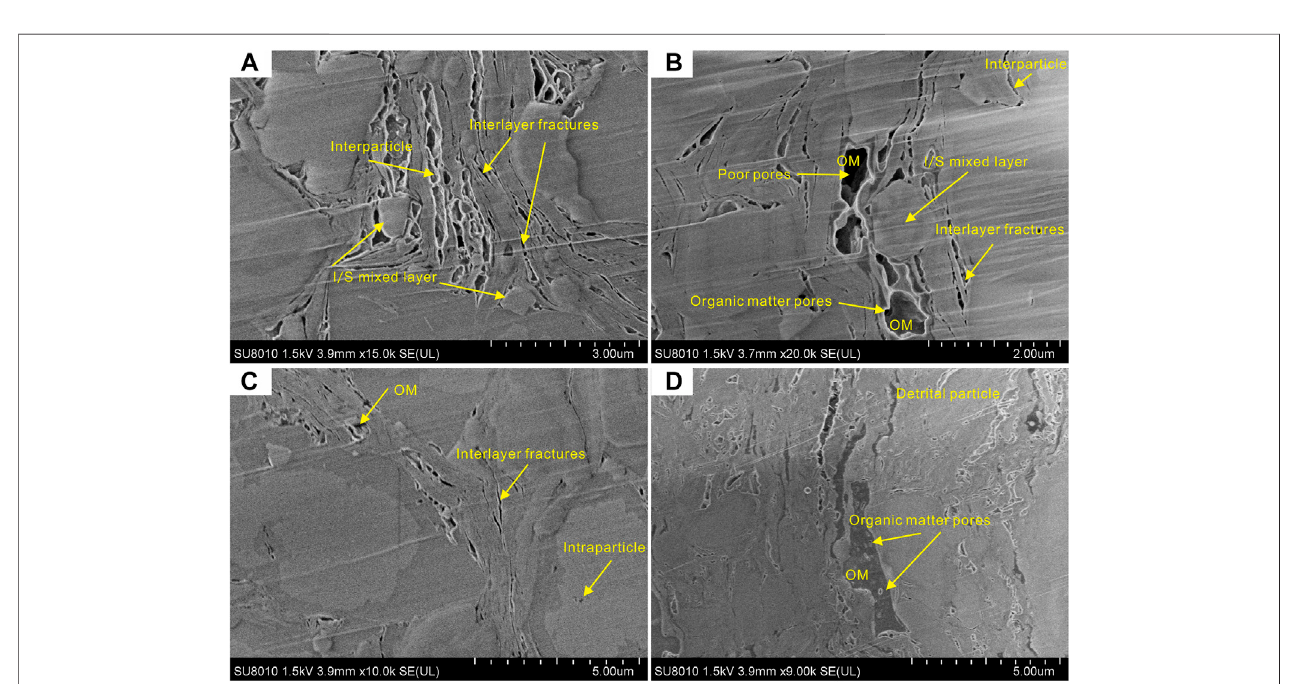
FIGURE 4 | Field emission scanning electron microscopy showing pore and fracture features of K 2 qn 1 samples.